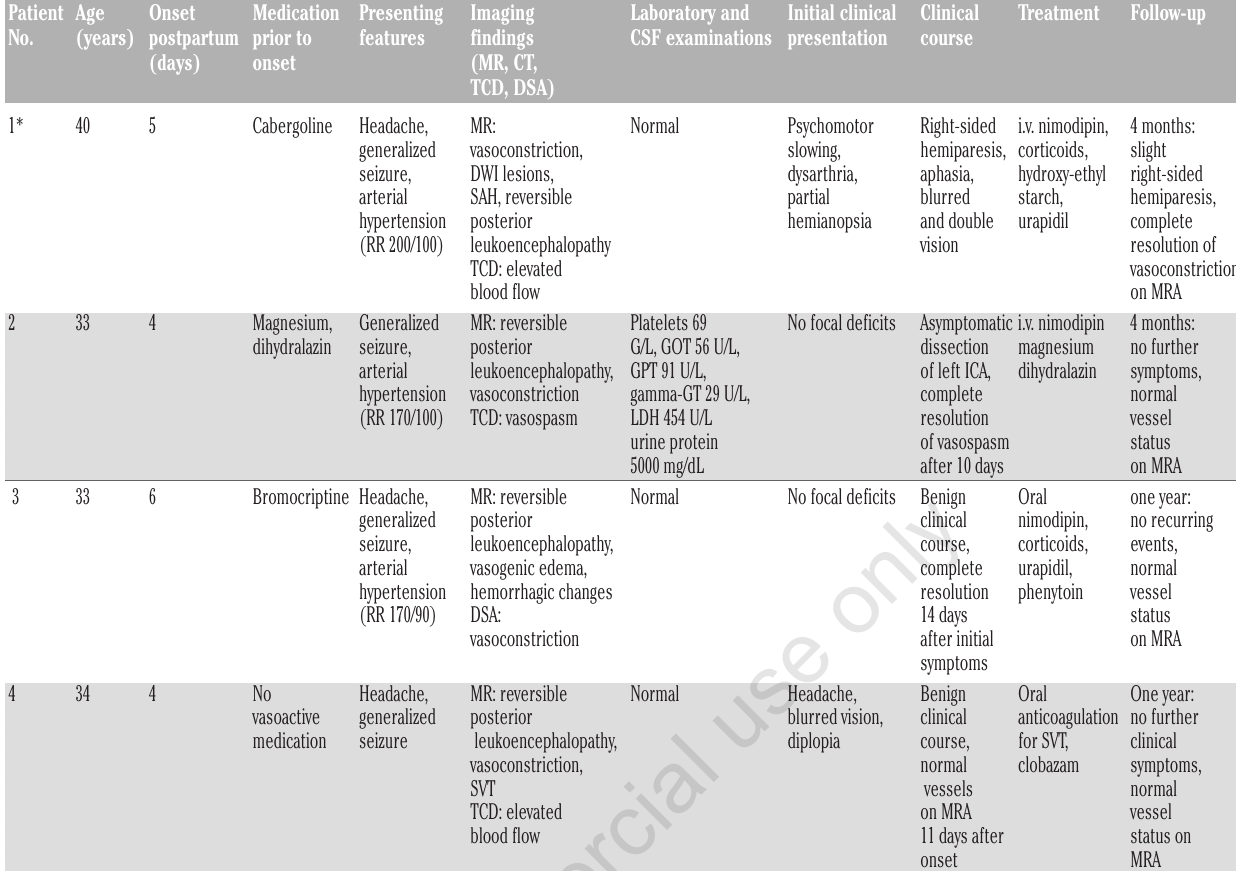
Table 1. Summary of all four